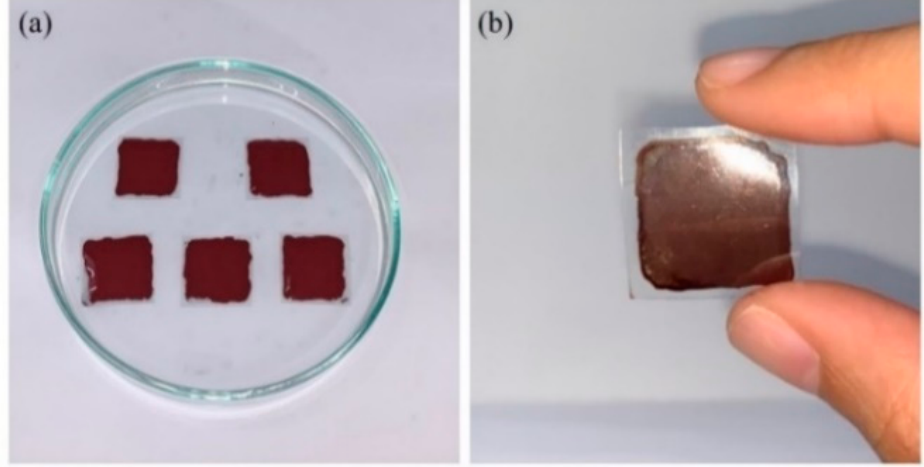
Figure 15. ( a ) PET substrates painted with conductive plasma. ( b ) Sample after sintering. Because the oven is not a complete vacuum, an oxidized microlayer formed on the copper surface. Further, because formic acid has decomposition properties that can transform cupric oxide into copper (II) formate, this salt compound decomposes easily after being heated, and after decomposition forms into copper [60]. The copper-conductive sheets sintered at a low temperature of 130 °C were treated with formic acid. A thin film analyzer was used to measure the average thickness of the film formed on the surface of PET, which was 3.96 μ m. Currently, ideal resistivity is approximately 10 –4 –10 –3 Ω ·cm; the resistivity resulting from various sintering times (30, 60, and 90 min) with 50% formic acid and a sintering temperature of 130 °C is presented in Figure 16a. The results indicate that after 30, 60, and 90 min of sintering, resistivity was 1.6 × 10 − 2 , 2.89 × 10 − 3 , and 2.87 × 10 − 3 Ω ·cm, respectively. Figure 16b presents the results of resistivity after 60 min of sintering at 130 °C and under different concentrations of formic acid. When the concentration of formic acid was 10%, no resistivity was detected. When the concentration was 30 and 70%, resistivity was 3.3 × 10 − 2 and 1.67 × 10 − 3 Ω ·cm, respectively. When the concentration of formic acid was 90%, resistivity began to increase.